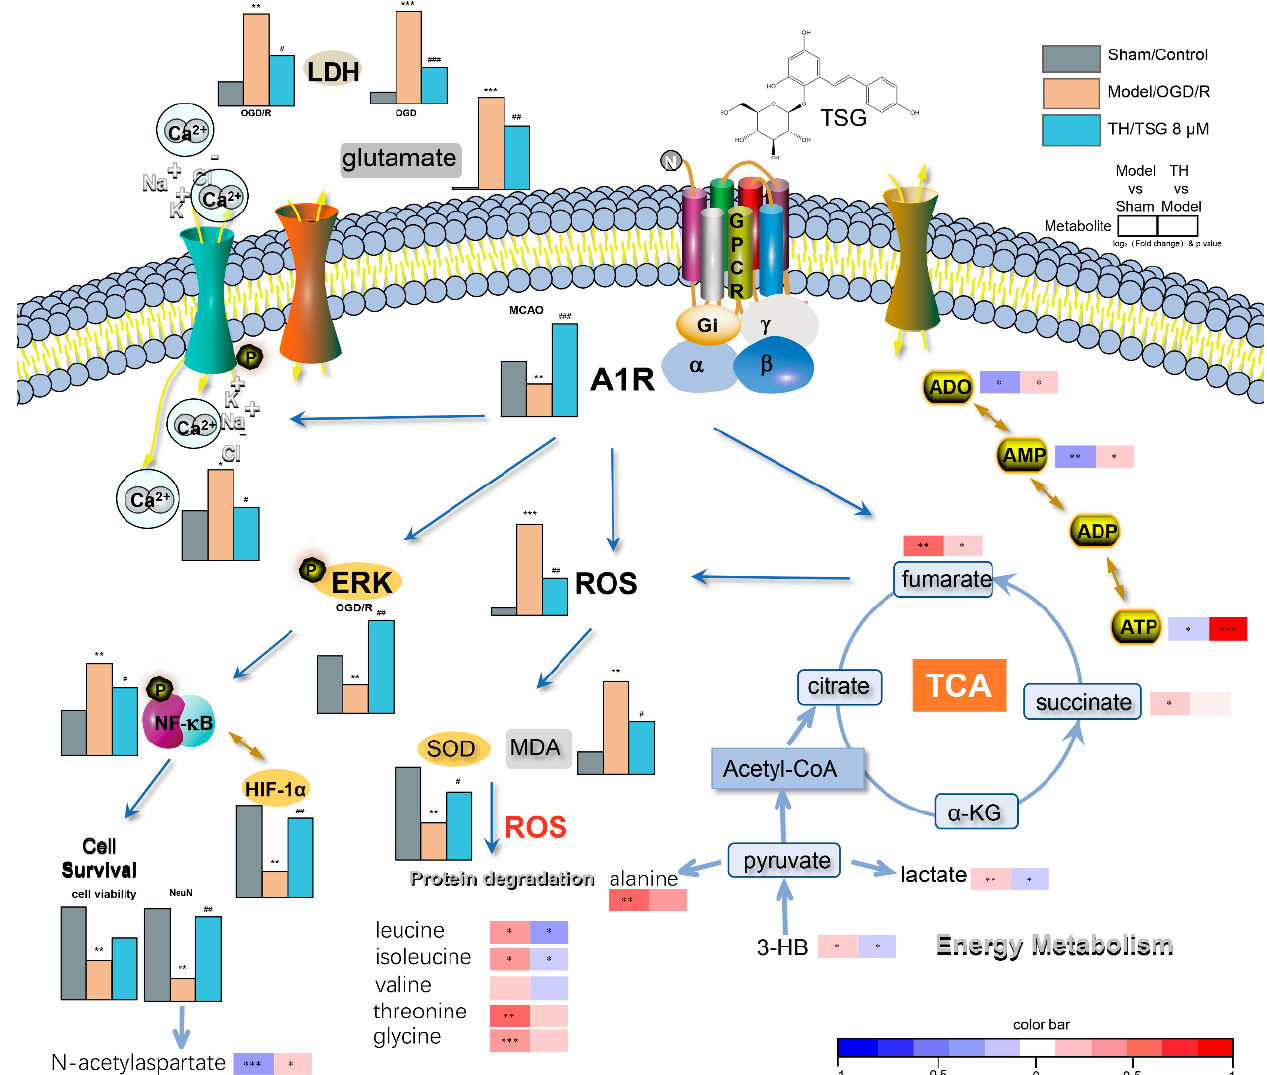
Figure 8. A schematic picture of TSG neuroprotection. TSG exerted its neuroprotective effect against cerebral I/R injury by activating A1R, upregulating its level, and triggering its downstream signaling pathways. TSG reversed the disturbed energy and amino acids metabolism in the brain of MCAO rats, ameliorated oxidative stress in vivo and in vitro. OGD/R induced Ca 2+ overload and excessive glutamate release, decreased phosphorylation of ERK1/2 and HIF-1 α stability and increased NF- κ B level, which could be reversed by TSG. α -KG, α -ketoglutarate; TCA cycle, tricarboxylic acid cycle. # p < 0.05, ## p < 0.01 and ### p < 0.001, other groups vs. model/OGD/R group; * p < 0.05, ** p < 0.01 and *** p < 0.001, other groups vs. sham/control group.